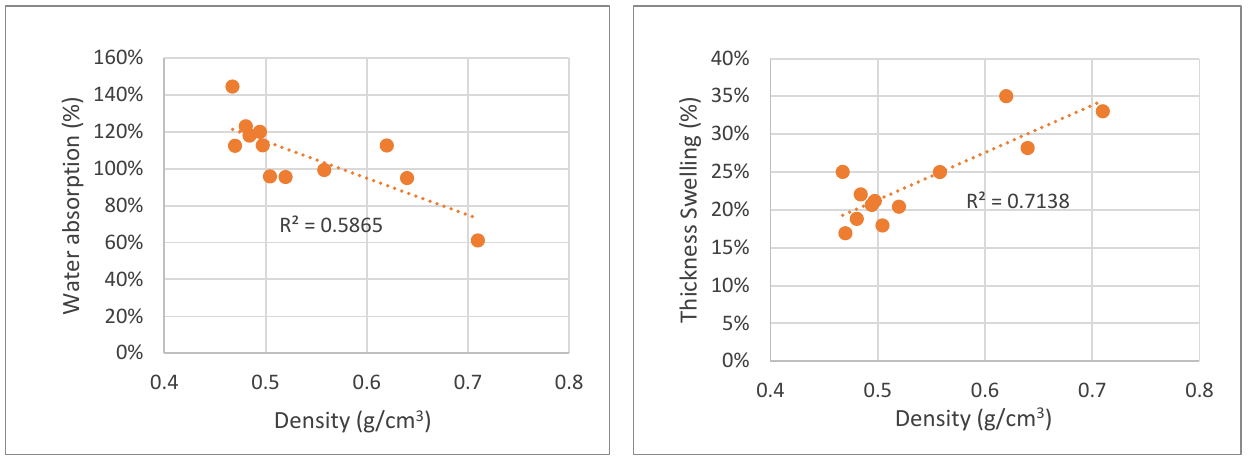
Figure 12. Correlation between water absorption and thickness swelling variation with particleboard density.